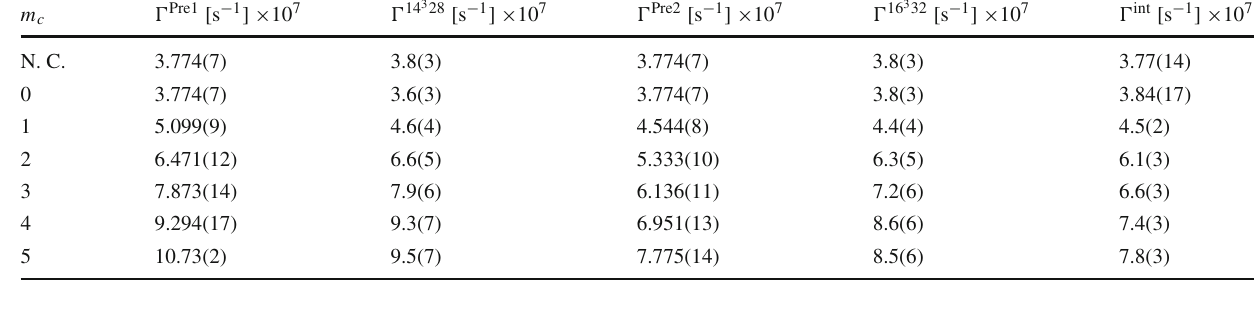
14 3 × 28, V = 16 3 × 32, and interpolated results, respectively. The predictions (cid:15) Pre1 and (cid:15) Pre2 are for the lattice volumes V = 14 3 × 28 ( V phys = 5 . 7845 [fm 4 ]) and V = 16 3 × 32 ( V phys = 9 . 8682 [fm 4 ]),